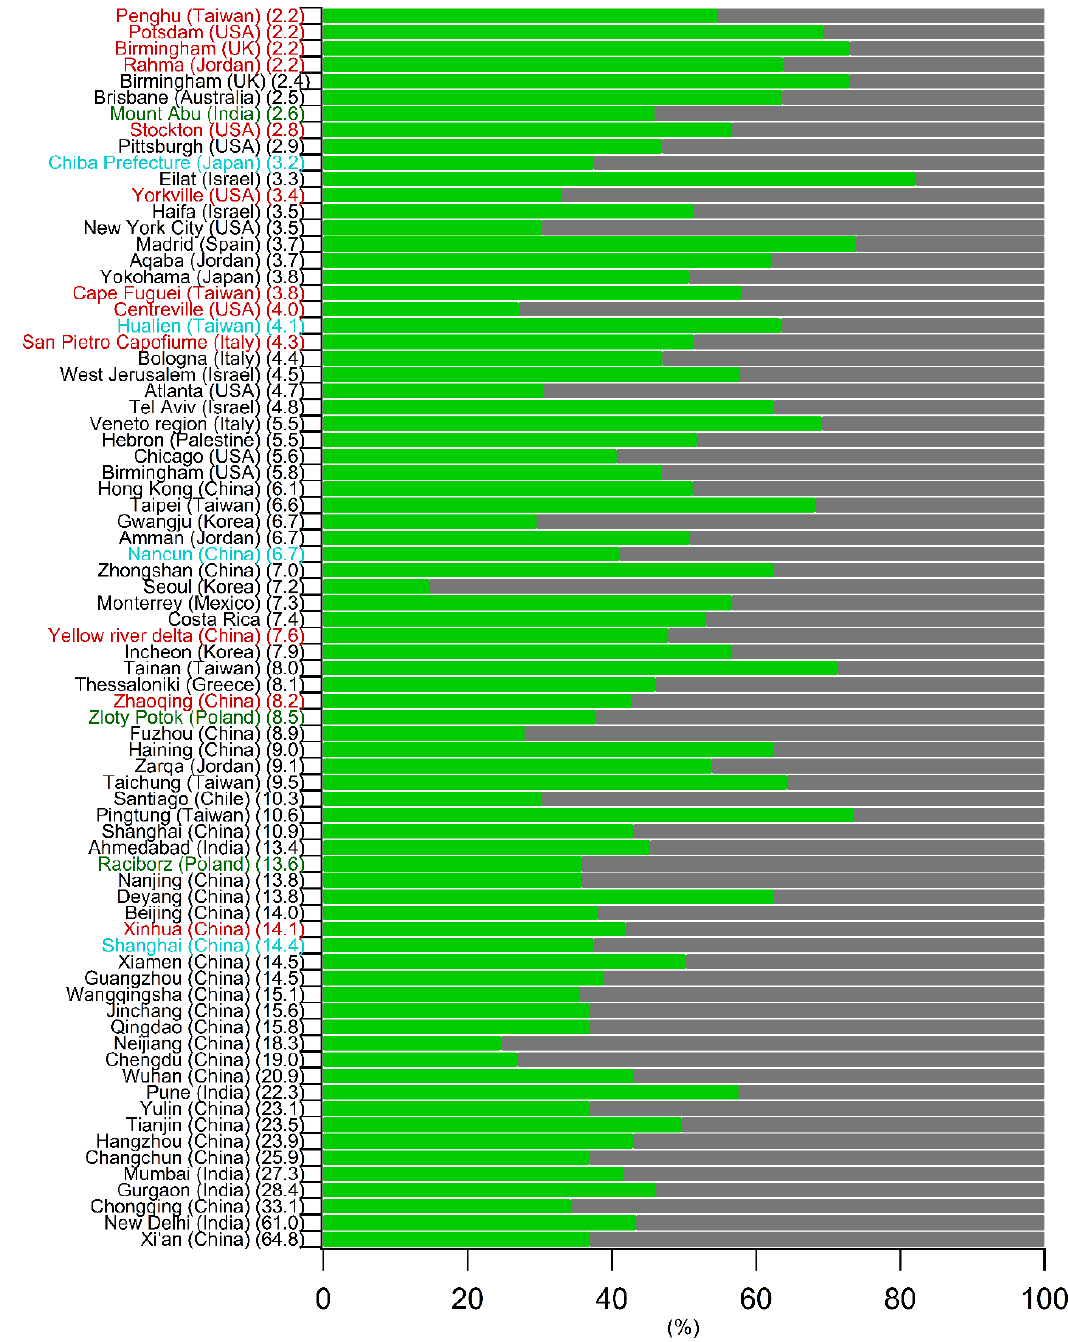
Figure 2. Annual secondary organic carbon (SOC) (green) and primary organic carbon (POC) (grey) contributions to PM 2.5 organic carbon (OC) estimated using the elemental carbon (EC) tracer method for all the monitored sites from 2006 to 2016. Results are presented in increasing order of OC concentration levels ( µ gC m − 3 ). In black, urban sites; in blue, suburban sites; in red, rural sites and in green, remote sites.